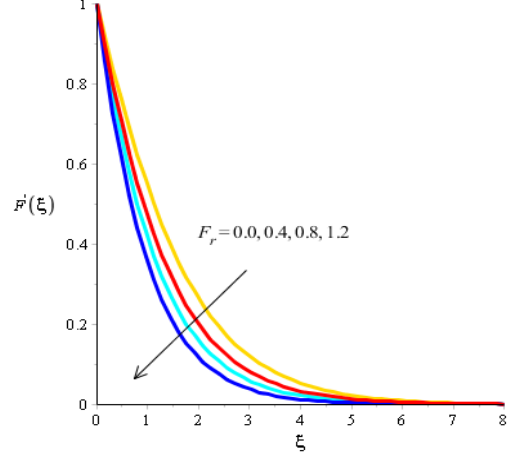
Figure 4. Analysis of velocity curves versus F r .